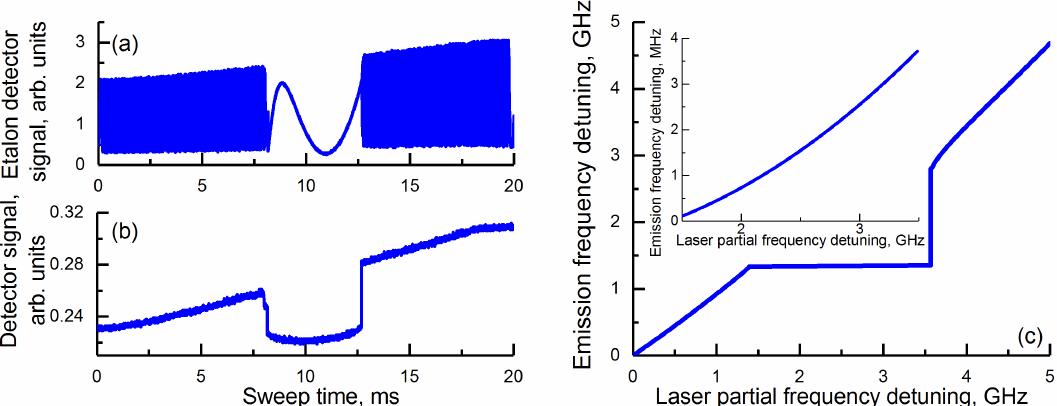
Figure 2. Measured dependence of the laser frequency ( a ), and power ( b ), on the laser current. The frequency is measured by sending laser light through an etalon while the power dependence is measured using a photodiode while laser current is scanning; ( c ) Dependence of the laser emission frequency on the partial frequency of the free running laser. Inset shows tuning of the self-injection locked laser within the locking range. The data are inferred from the measurement results shown in panel ( a